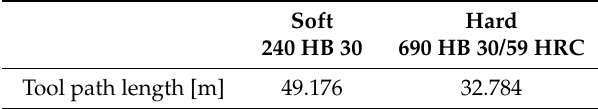
Table 13. Overview of tool path lengths.